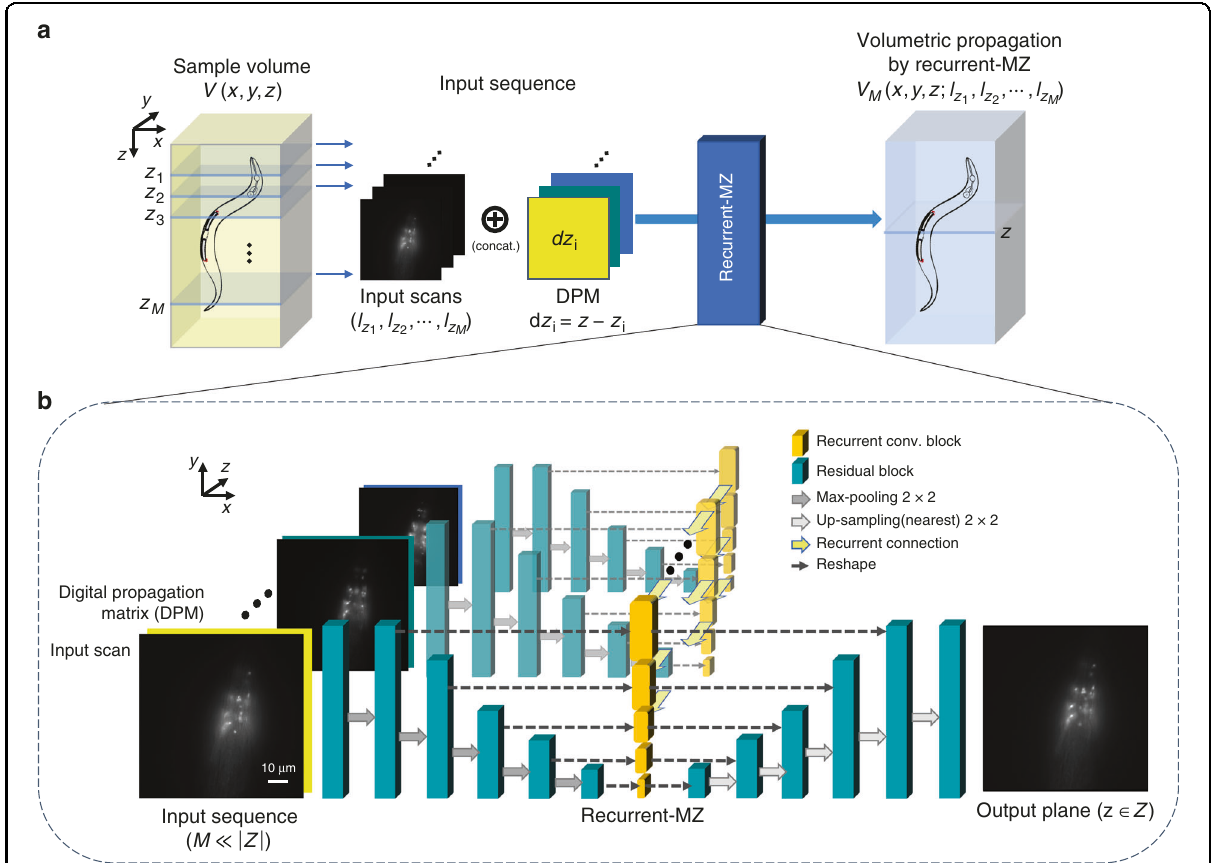
Fig. 1 Volumetric imaging through Recurrent-MZ. a Recurrent-MZ volumetric imaging framework. M is the number of input scans (2D images), and each input scan is paired with its corresponding DPM (Digital Propagation Matrix). b Recurrent-MZ network structure. The network and training details are elucidated in the Materials and Methods section. Z is the set of all the discretized axial positions within the target sample volume, composed of | Z | unique axial planes. Typically, M = 2 or 3 and | Z | ≫